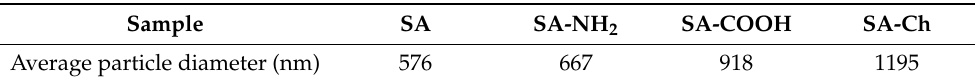
Figure 5. Particle diameter distribution of the original and modified SAs. Table 1. Average particle diameter of SA, SA-NH 2 , SA-COOH, and SA-Ch.